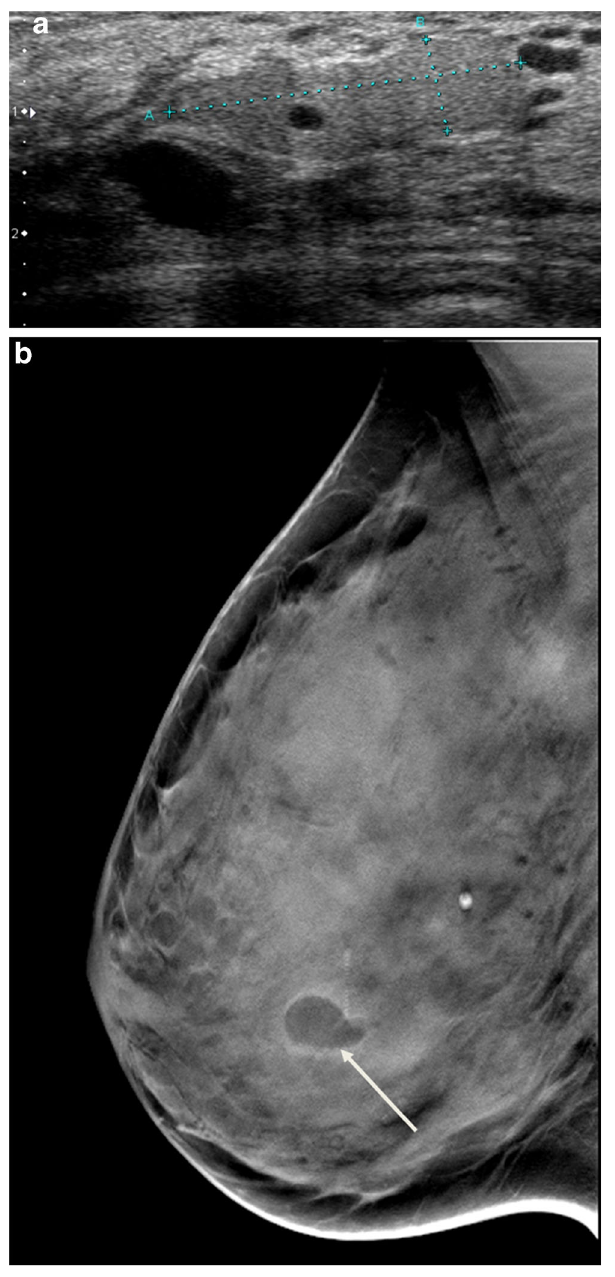
Fig. 8 Galactocele. a Ultrasound scan showing duct dilatation with homogeneous hyperechoic content, with no blood supply demonstrated by colour Doppler, in a schizophrenic patient with long-term neuroleptic treatment. b Digital breast tomosynthesis in the same patient showing a fat density galactocele ( arrow